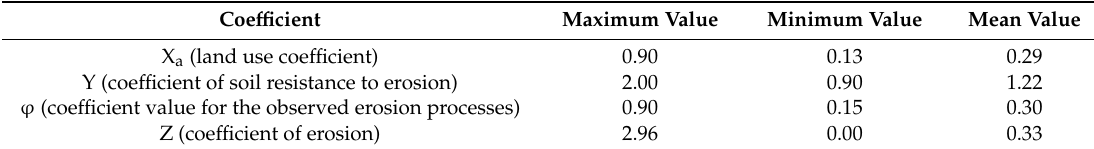
Table 6. Coe ffi cient values.